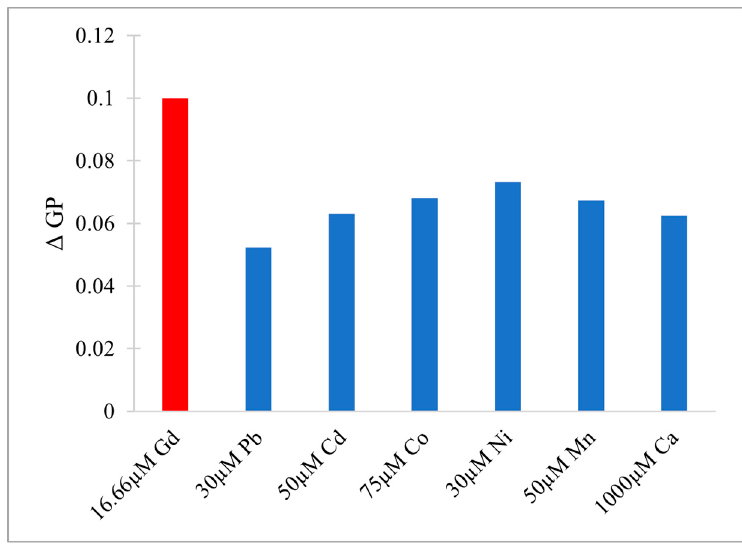
Figure 7. Generalized polarization of POPS liposomes in the presence of various heavy metals. The graph is compiled from different studies that were designed to characterize single metals and thus the concentration ranges used vary.